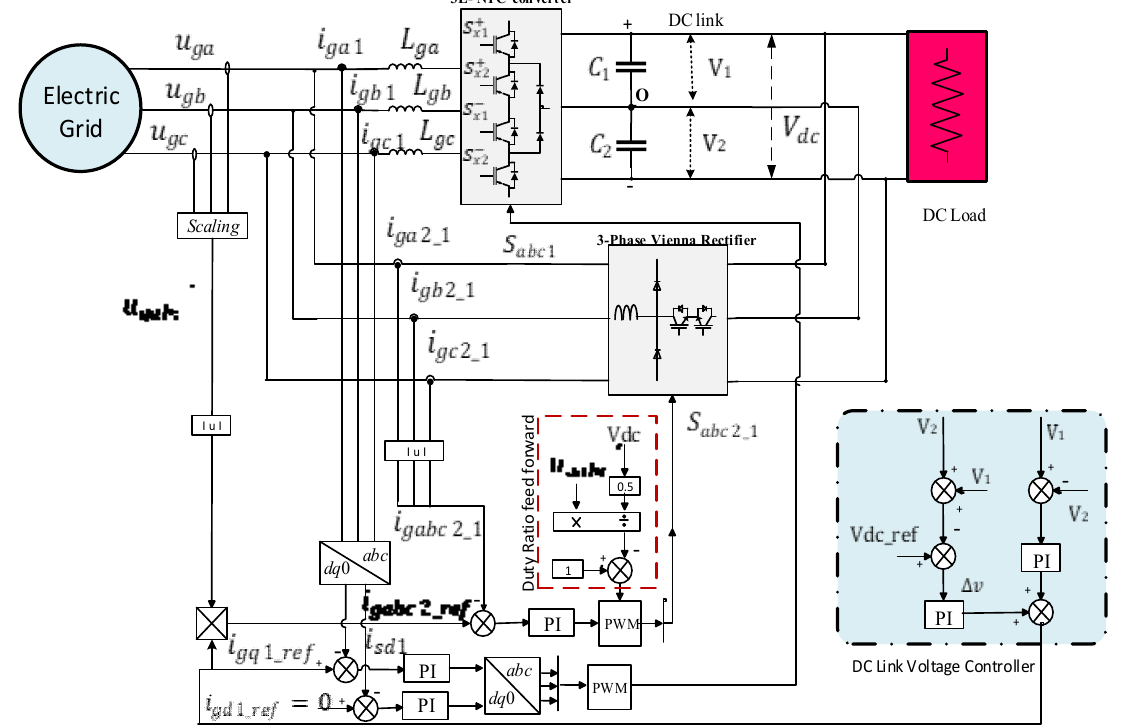
Figure 5. Diagram of simulated and Implemented system.